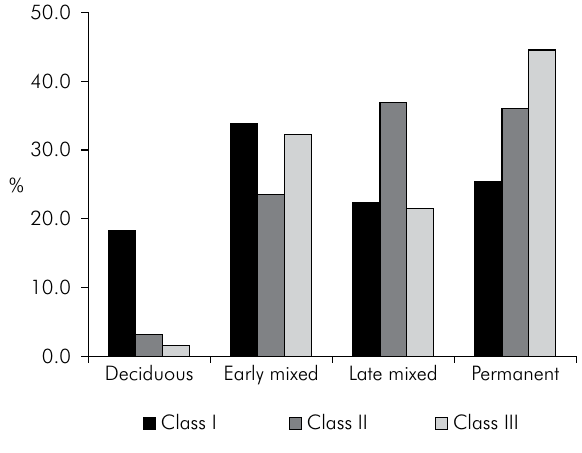
Figure 1. Distribution of sagittal occlusal relationships in subjects of each dentition stage.